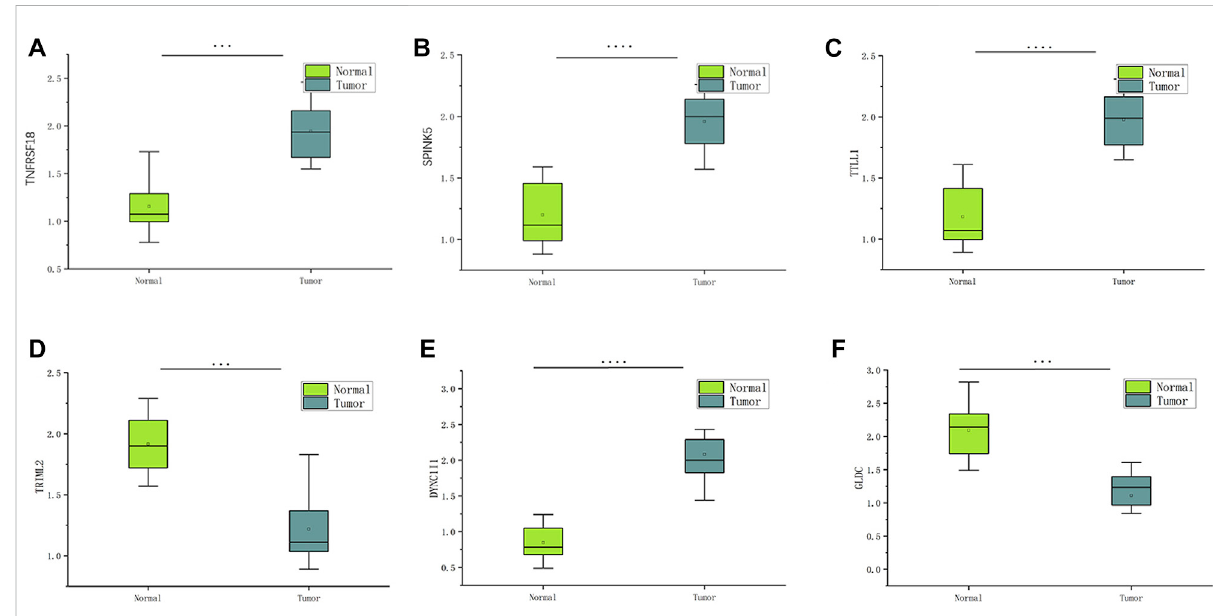
FIGURE 11 The expression of six pyroptosis-related genes in HNSCC and paracancerous tissues was measured by qRT-PCR. ppp p < 0:001and pppp p < 0: 0001.